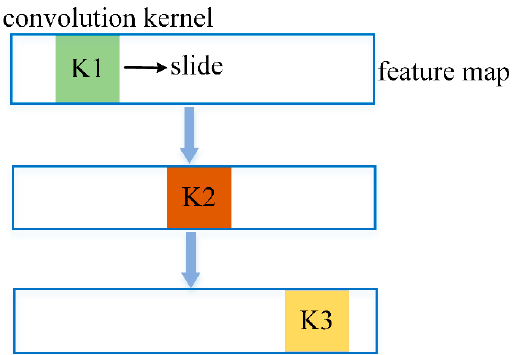
Figure 3. The sketch of unshared convolution. K1, K2, and K3 denote convolution kernels with different weight parameters.